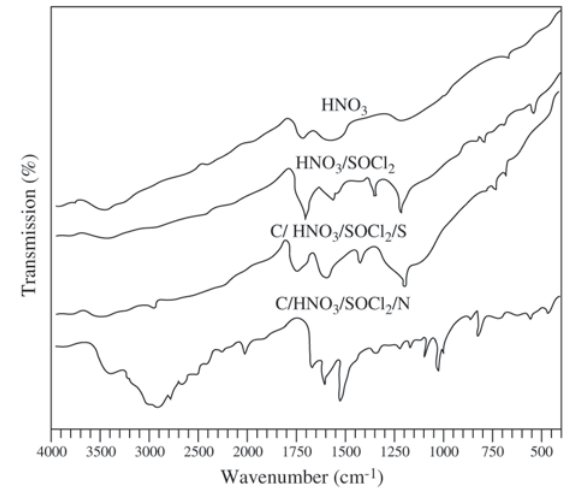
Figure 9. IR spectra for the (a) carbon treated with HNO (b) after reaction with SOCl (c) HSCH CH SH (EDT) or (d) H 2 2